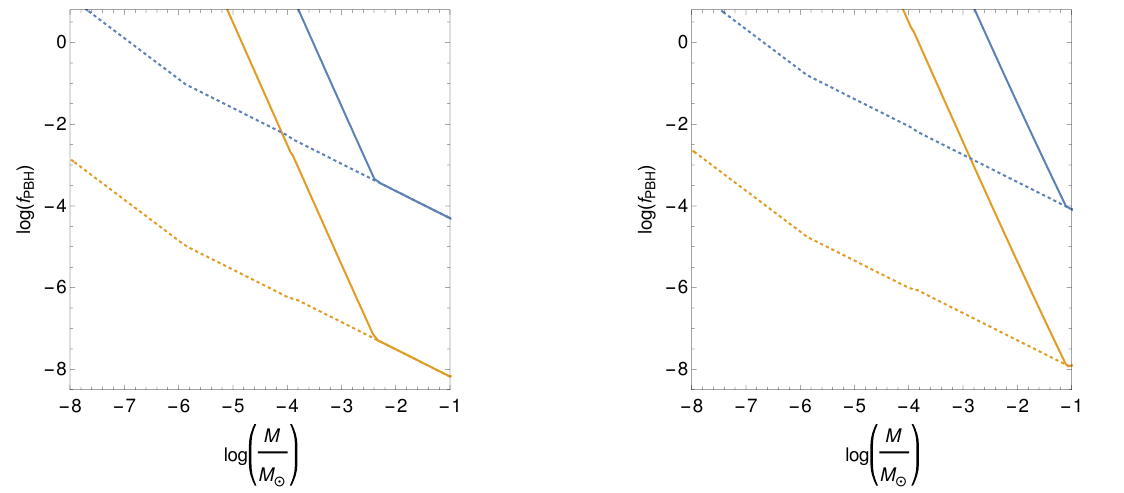
Figure 1 . Constraint on the PBH abundance f PBH as a function of PBH mass. The blue and orange lines are the constraints from COBE and future PIXIE experiments, respectively. The solid and dotted lines are for the constraint with and without considering the photon amplitude saturation by the Schwinger pair production, respectively. For M . 10 (cid:0) 6 M (cid:12) , we have used the same assumption as ref. [16]. We have taken (~ a; f ~ a ) = (1 ; 1) in the left panel and (~ a; f ~ a ) = (0 : 6 ; 10 3 ) in the right